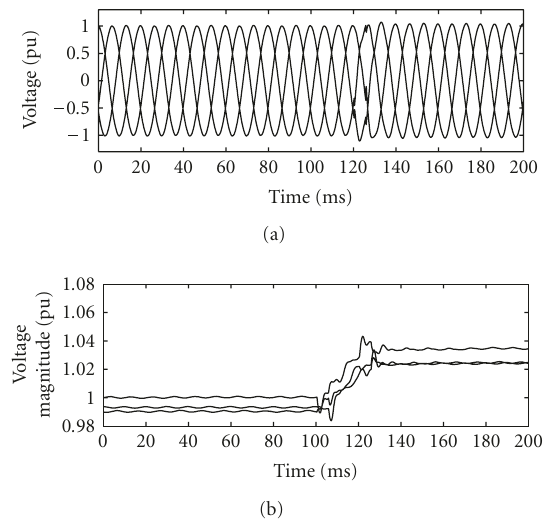
Figure 7: Voltage disturbance due to capacitor energizing: (a) volt- age waveforms; (b) voltage magnitude (measurement in a 10kV